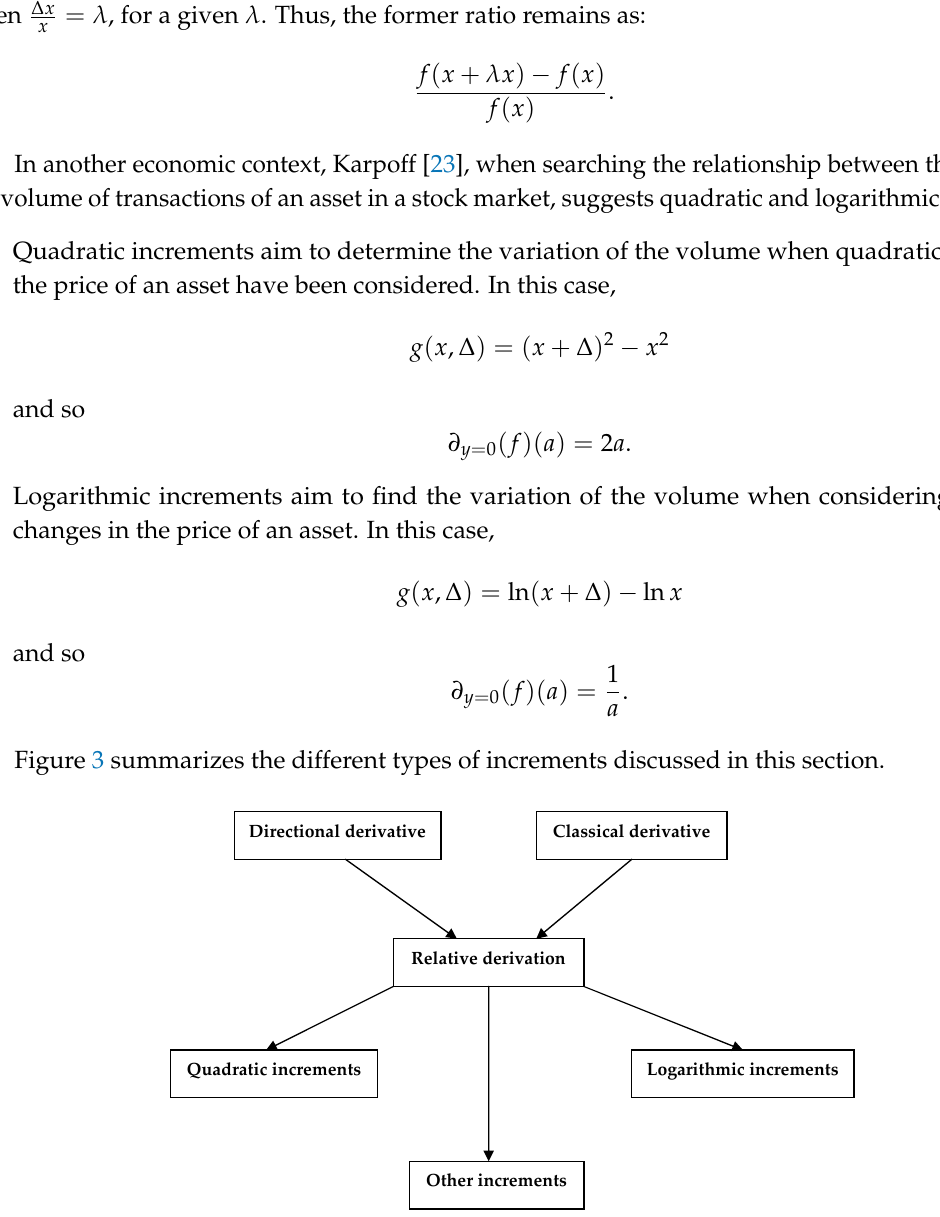
Figure 3. Chart of the different types of